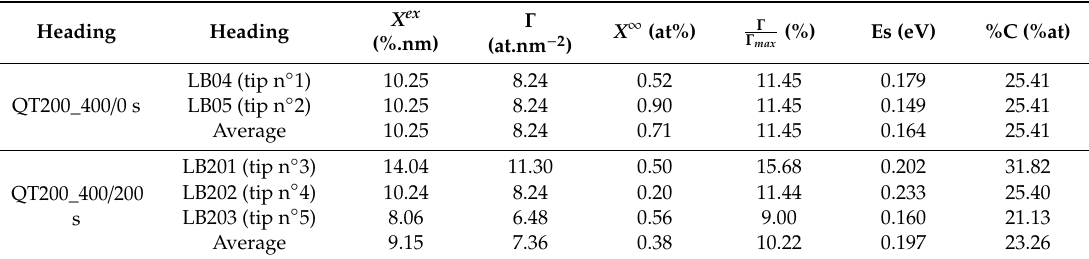
Table 4. Results of the measurements of carbon segregation on lath boundaries for di ff erent Q&P